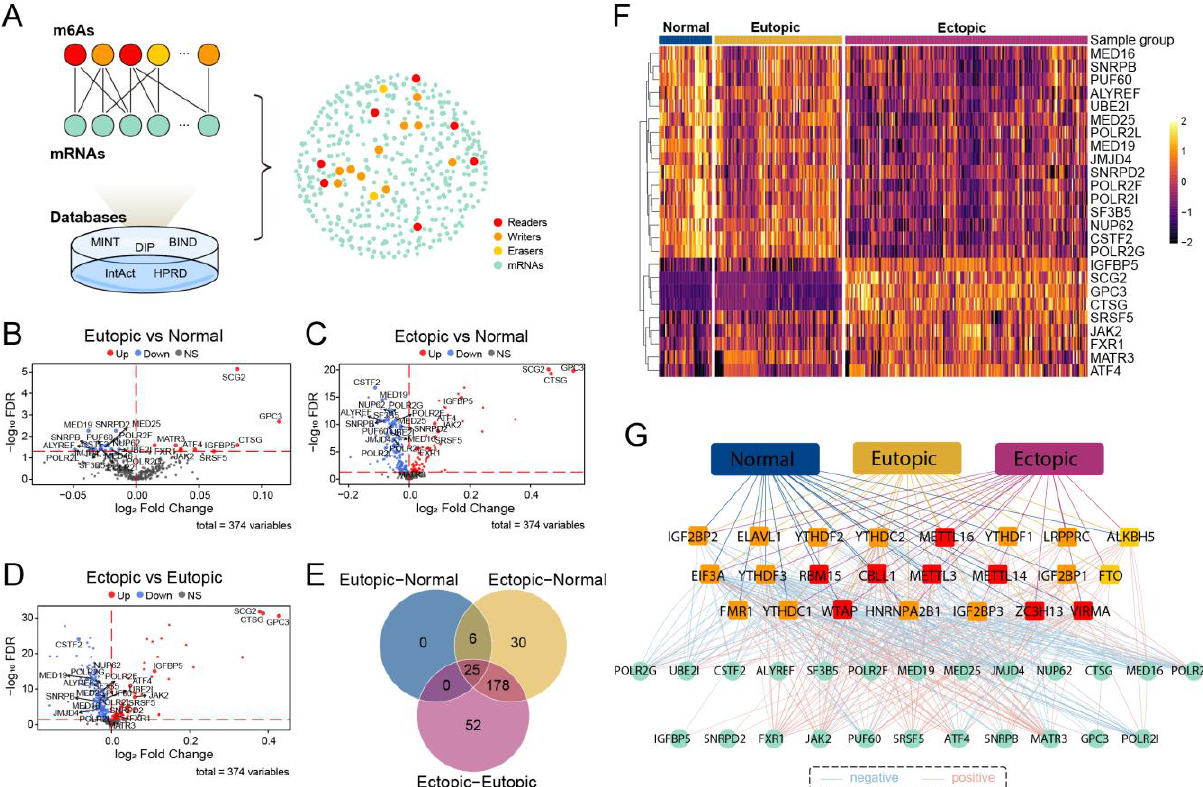
Figure 3. Analysis of m6A regulators-related mRNAs. ( A ) A comprehensive network was extracted from m6A regulators and their nearest neighbor mRNAs in five experimentally validated databases. ( B – D ) The volcano plots showed significant variations in these related mRNAs in eutopic vs. normal, ectopic vs. normal, and ectopic vs. eutopic groups. The upregulated genes marked in red, the downregulated in blue and gray indicated not differential expressed. The overlapping mRNAs among 3 differential results were exhibited in the Venn plot ( E ), and their expression in the heatmap ( F ). ( G ) A robust MACN consisted of m6A regulators with interacting mRNAs in normal, eutopic and ectopic groups. The blue lines represented negative correlations, and red ones pointed to the positive.